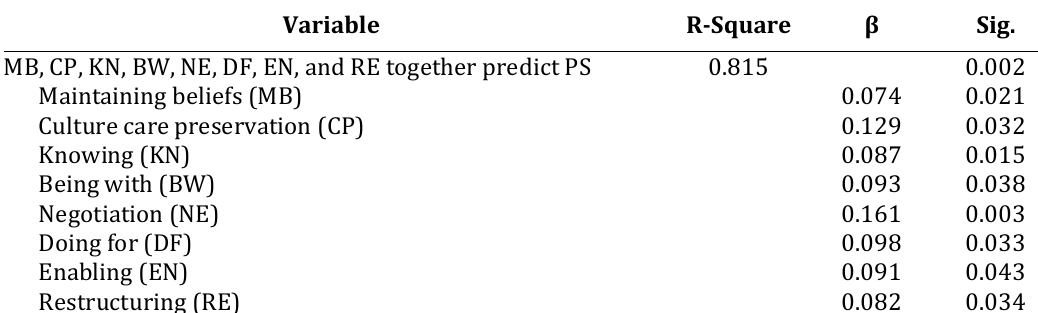
Table 3 Multiple Linear Regression Test Variable R-Square β